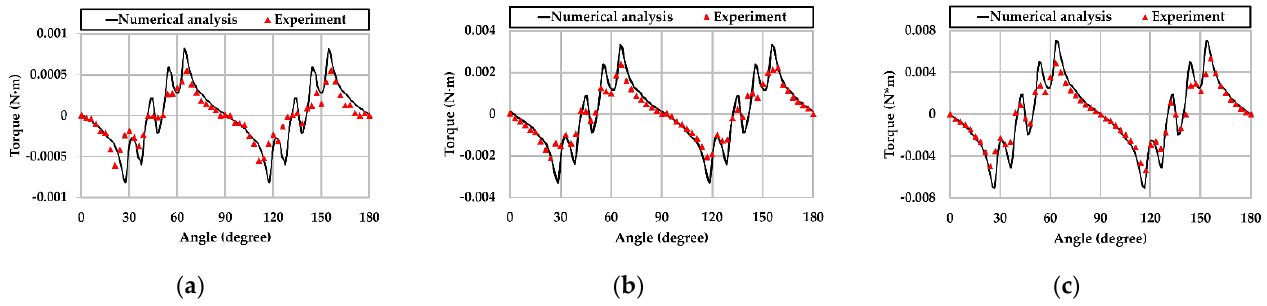
Figure 3. The rotor torque by pressure of the magnetic fluid, that is, the output torque of the experimental motor graph, when the input current is ( a ) 0.32 A, ( b ) 0.65 A, ( c ) 0.97 A. In numerical analysis, the interval is 1 degree. In the experiment, the interval is 3 degrees.